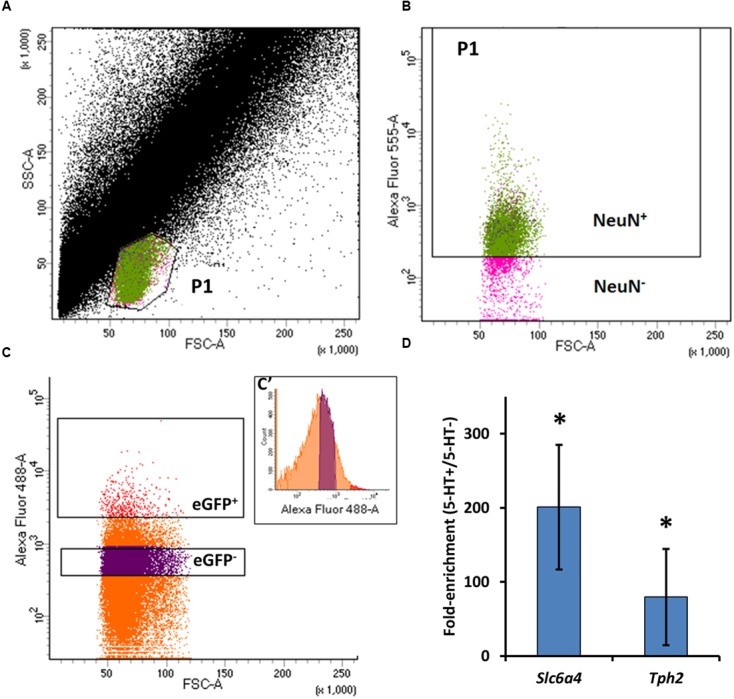
Methods for FACS collection of dissociated eGFP-expressing (eGFP+) and non-eGFP (eGFP-) medullary raphe neurons. (A) Representative data plotting forward-scatter (FSC) versus side-scatter (SSC) of all recorded sort events (cells). An area (P1) was identified as inclusive of raphe neurons, confirmed in (B) by sorting and plotting the FSC versus NeuN fluorescence of NeuN-labeled (Alexa Fluor 546-tagged) cells (Green events in A and B). (C) Gate establishment for the identification of eGFP+ (5-HT neurons) from ePet-eGFP:SS brainstem tissues by plotting FSC and the fluorescence intensity of Alexa Fluor 488 from collected P1/NeuN+ events, designated eGFP+ (red) or eGFP- (purple). (C’) The distribution of Alexa Fluor 488 intensity versus event counts. (D) qPCR data showing fold-enrichment of 5-HT neuron-specific genes slc6a4 (SERT) and tph2 (tryptophan hydroxylase 2) in eGFP+ (5-HT-enriched) versus non-5-HT neuron-enriched cell pools (P < 0.05; One-way ANOVA).